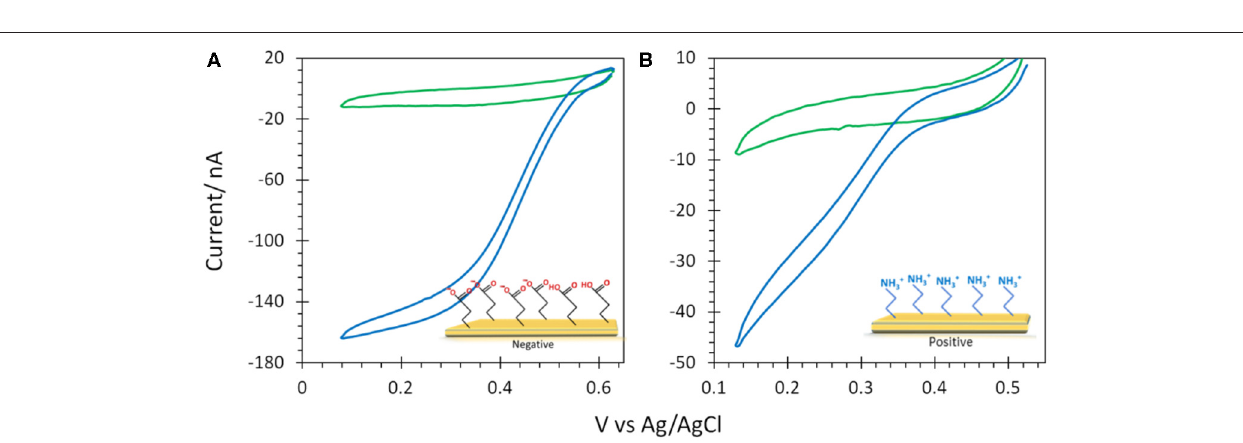
FIGURE 7 | CVs obtained under N 2 (green) and O 2 (blue) after (A) Mv BOD adsorption on 6-MHA and (B) Tt LAC adsorption on CYST functionalized Au-film@ITO (30nm) electrodes. Scan rate 10 mV/s, 100mM phosphate buffer pH 6 for Mv BOD and acetate buffer pH 5 for Tt LAC. Enzyme adsorption was made at 4 ◦ C and electrochemistry is carried out at 25 ◦